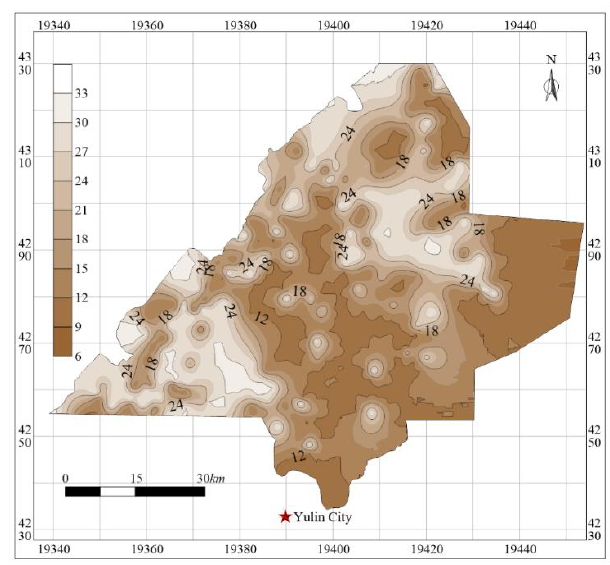
Figure 15. Protection zone thickness contour (Xi'an geodetic coordinate system 1980; in km).